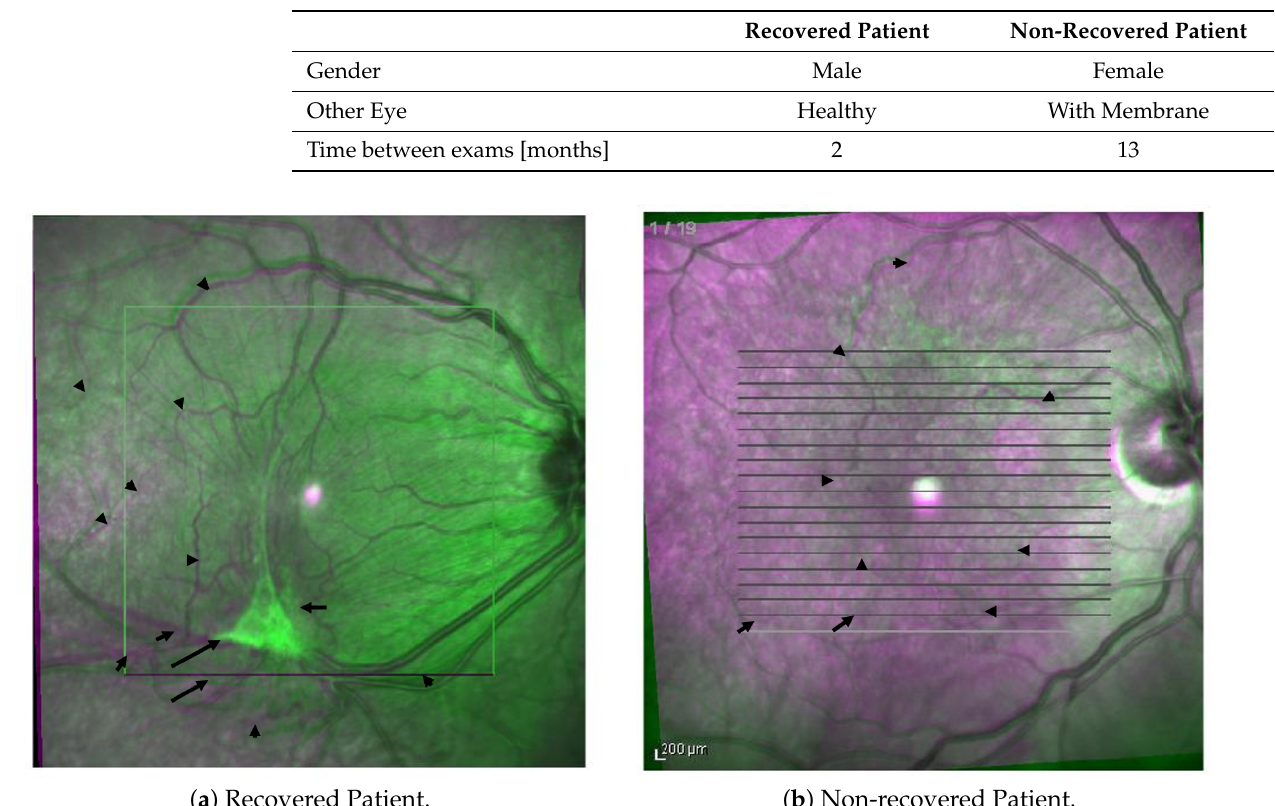
Table 2. Patients characteristics.